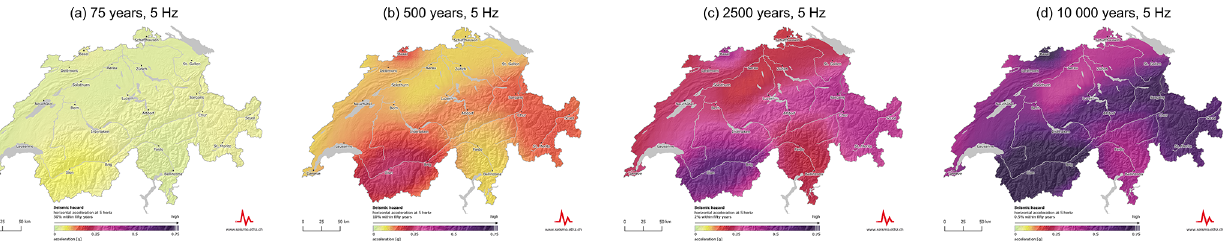
Figure 3. Same color scale for hazard maps with different return periods. From left to right are return periods of (a) 75 years, (b) 500 years, (c) 2500 years, and (d) 10000 years (Swiss Seismological Service, 2018; http://www.seismo.ethz.ch/knowledge/seismic-hazard-switzerland/ maps/hazard/, last access: 22 November